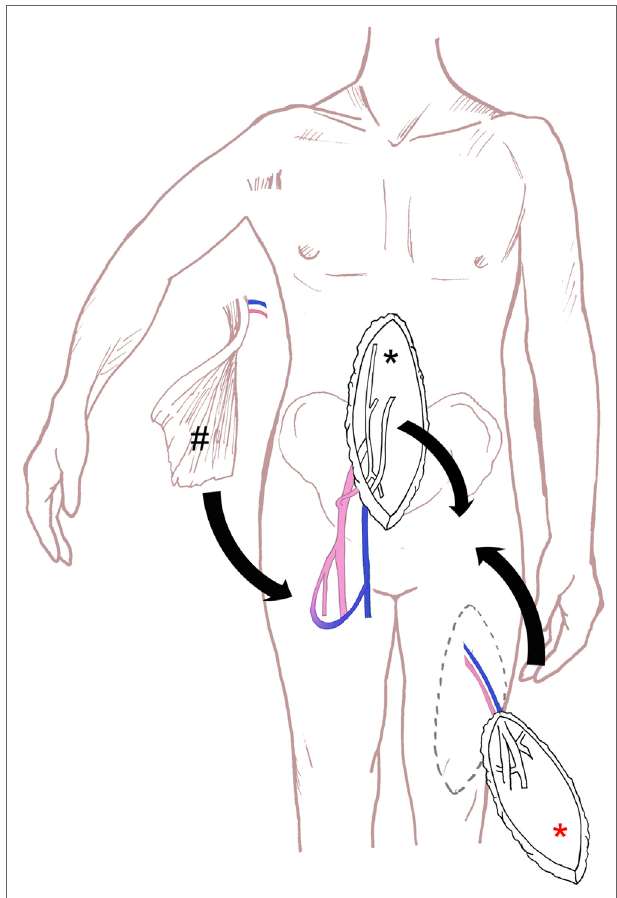
FiGURe 4 | Schematic drawing of the surgical technique for perineal defect reconstruction, with schematic drawing of vRAM flap (black asterisk), ALT flap (red asterisk) and microsurgical free latissimus dorsi flap and an arterio-venous loop (hash)